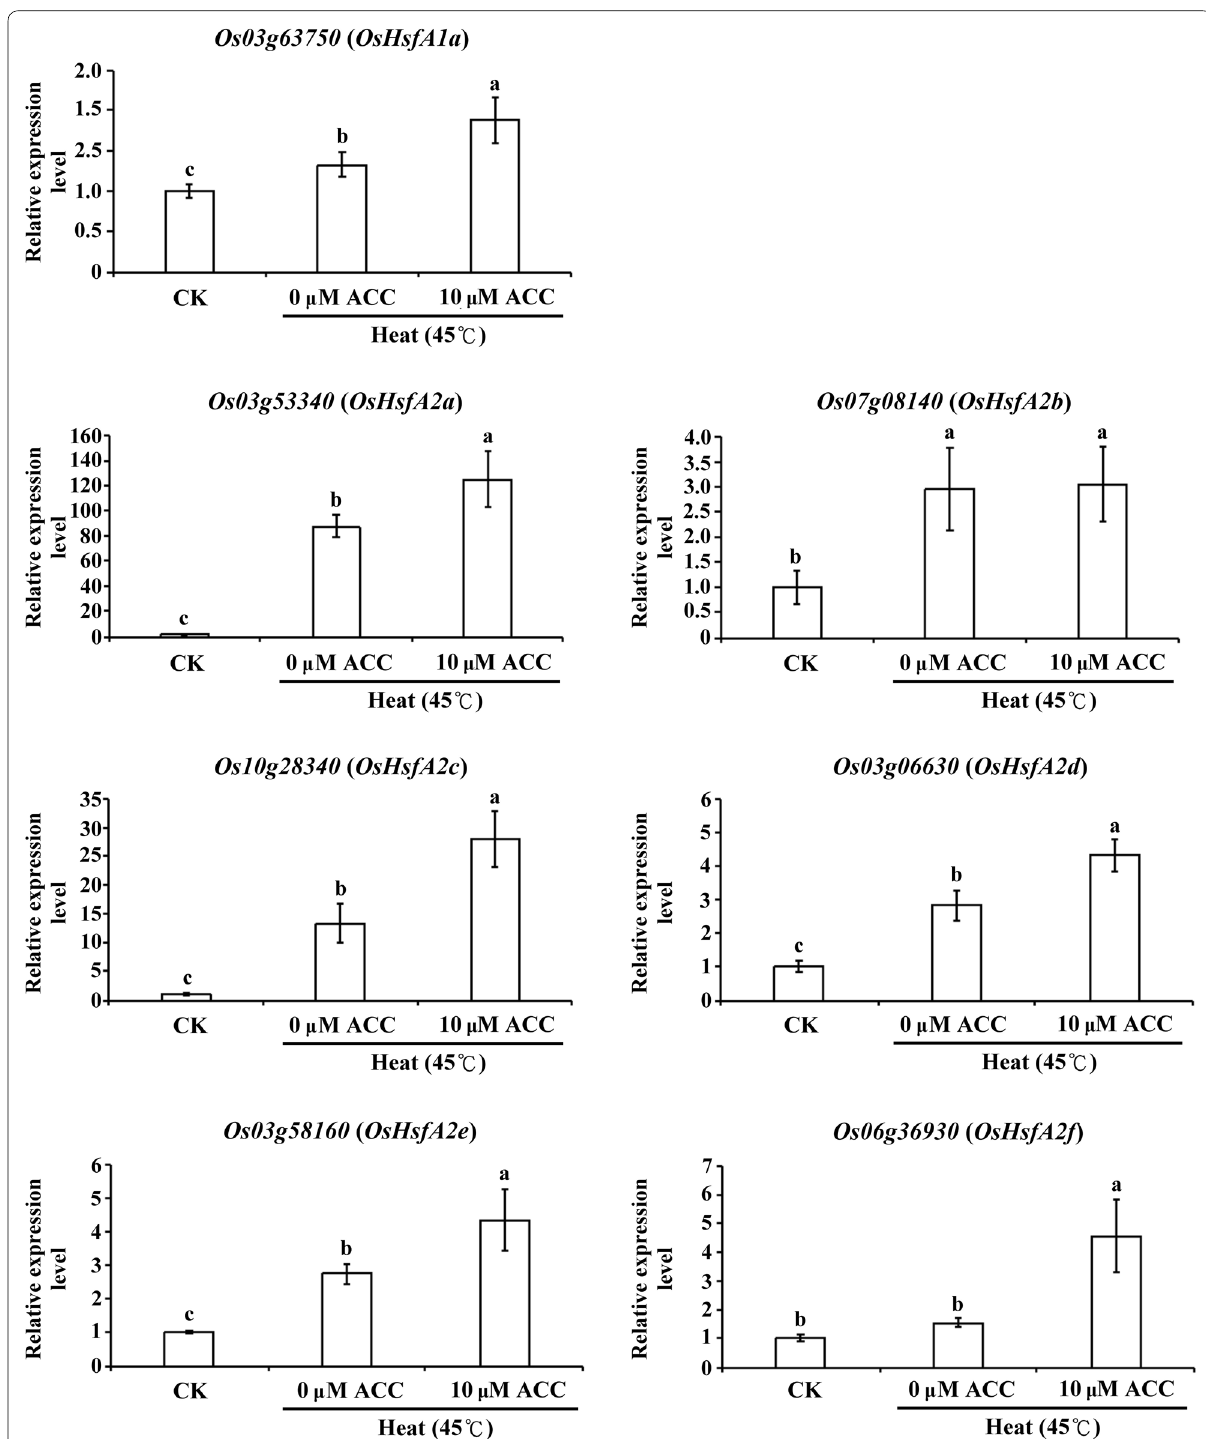
Fig. 4 Transcript levels of heat shock factor genes under heat stress with ACC treatment. Total RNA was isolated from the shoots of 12‑day‑old seedlings after heat stress (45 °C) with or without 10 µM ACC for 1 h. Relative expression levels of Os03g63750 ( HsfA1a ), Os03g53340 ( HsfA2a ), Os07g08140 ( HsfA2b ), Os10g28340 ( HsfA2c ), Os03g06630 ( HsfA2d ), Os03g58160 ( HsfA2e ), and Os06g36930 ( HsfA2f ) were determined through quantitative RT‑PCR. Control check (CK). Values are presented as mean standard deviation based on 30 seedlings of each treatment obtained from ± six biologically independent experiments. Different letters indicate significant difference between the treatments assessed using the LSD post hoc test ( P <